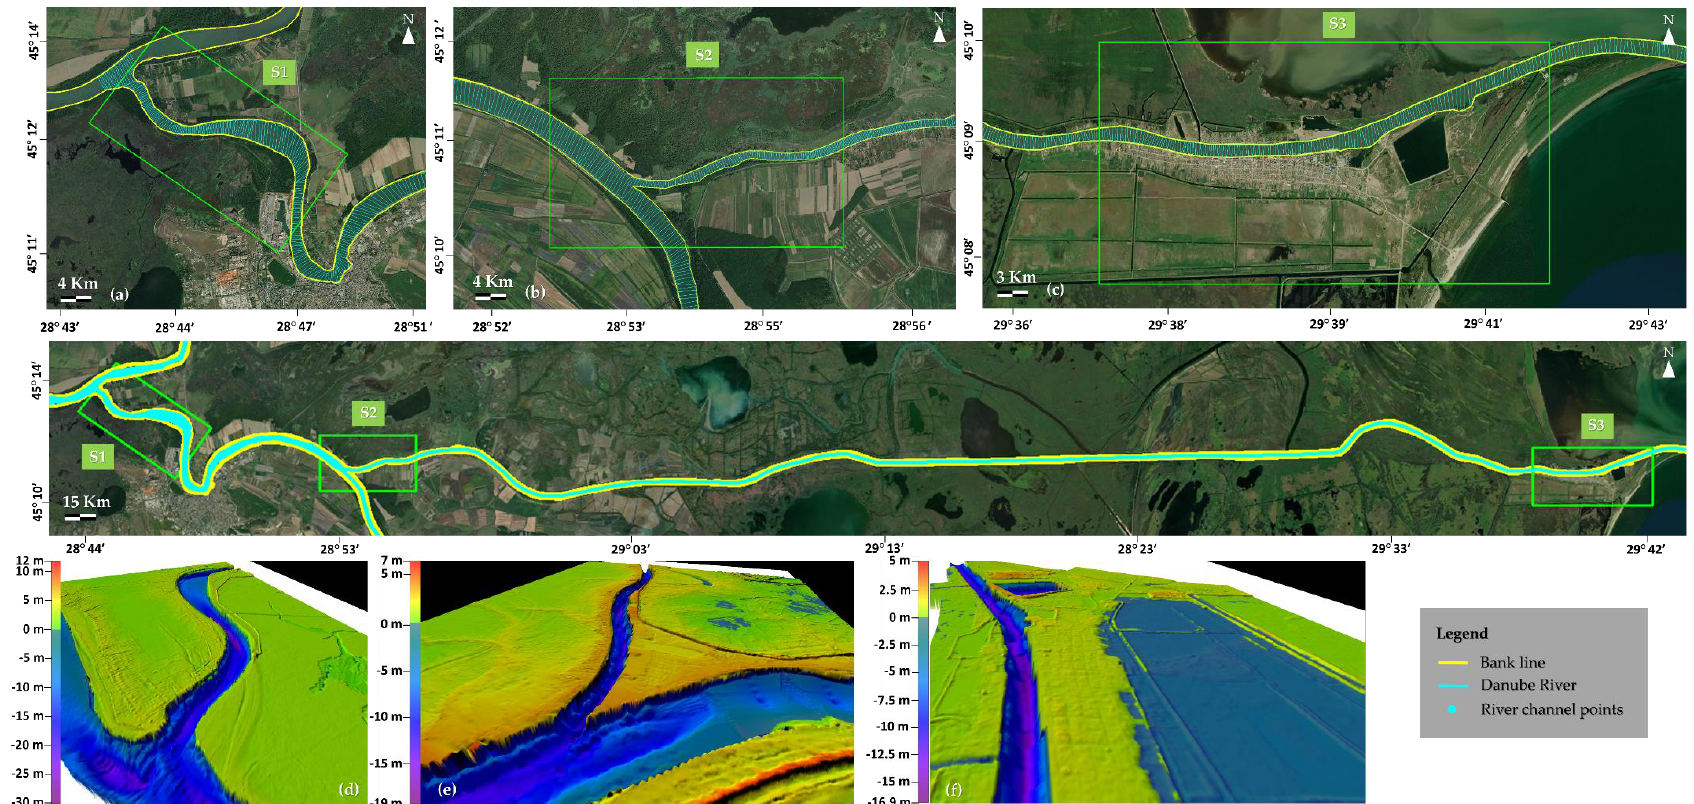
Figure A3. Bathymetric cross-section profiles (magenta lines) and bank points (yellow dots), measured for S1 ( a ), S2 ( b ), and S3 ( c ), sections of the study area. The third line subfigures ( d – f ) represents the combined 3D model obtained from LIDAR and bathymetric data for all three sections of the study area.